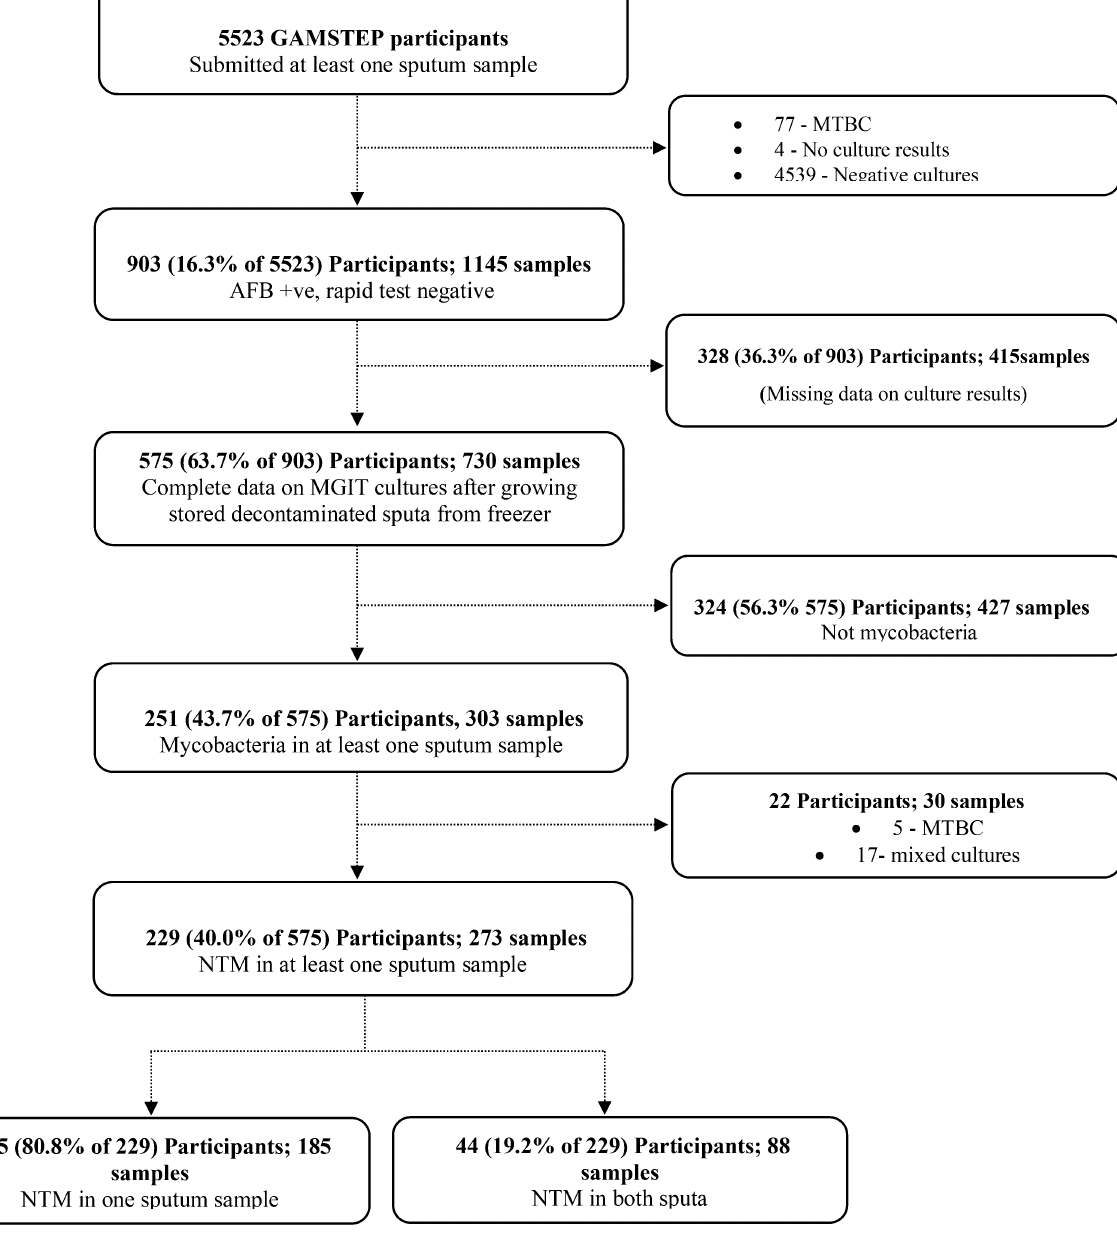
Figure 1. Outline of the non-tuberculous mycobacteria study in The